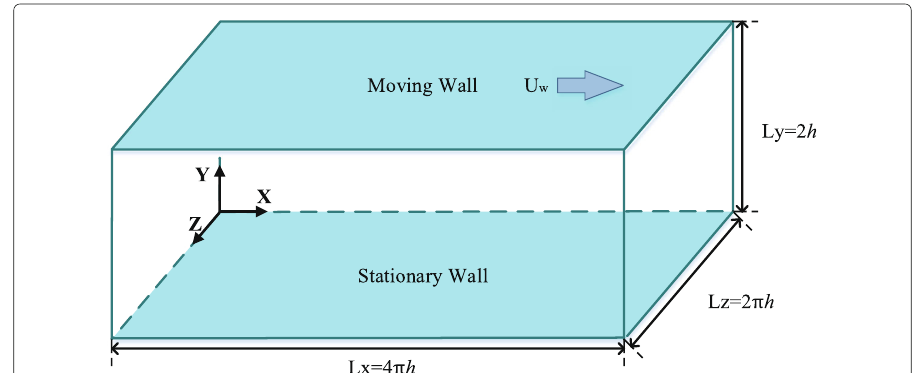
Fig. 8 The flow domain and coordinate system of the turbulent plane Couette flow